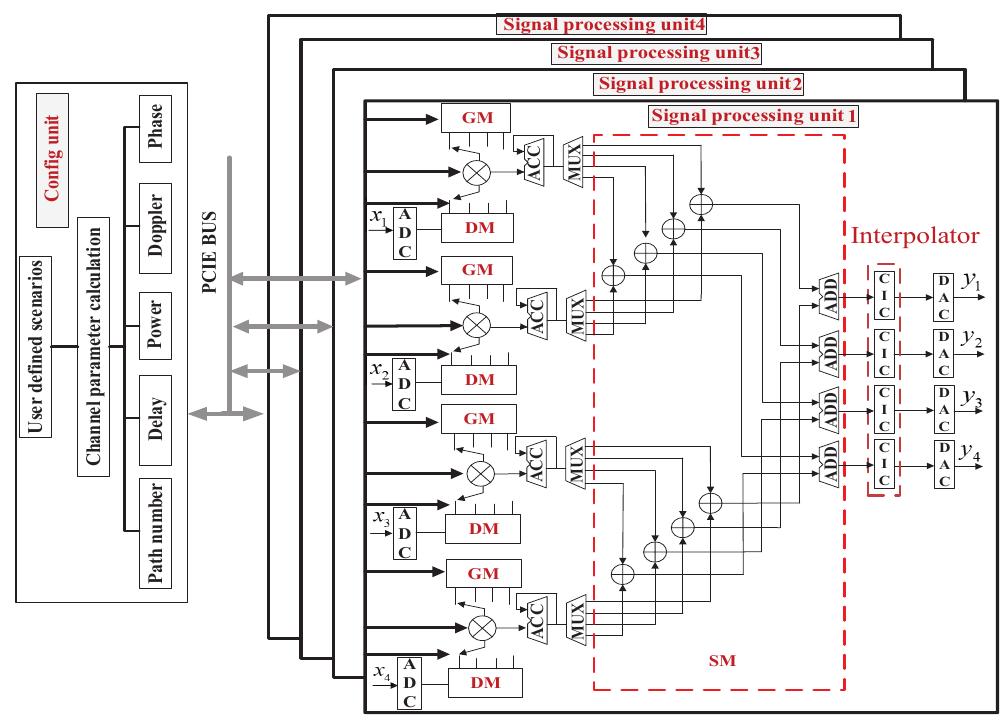
Figure 1. System architecture of the proposed emulator.